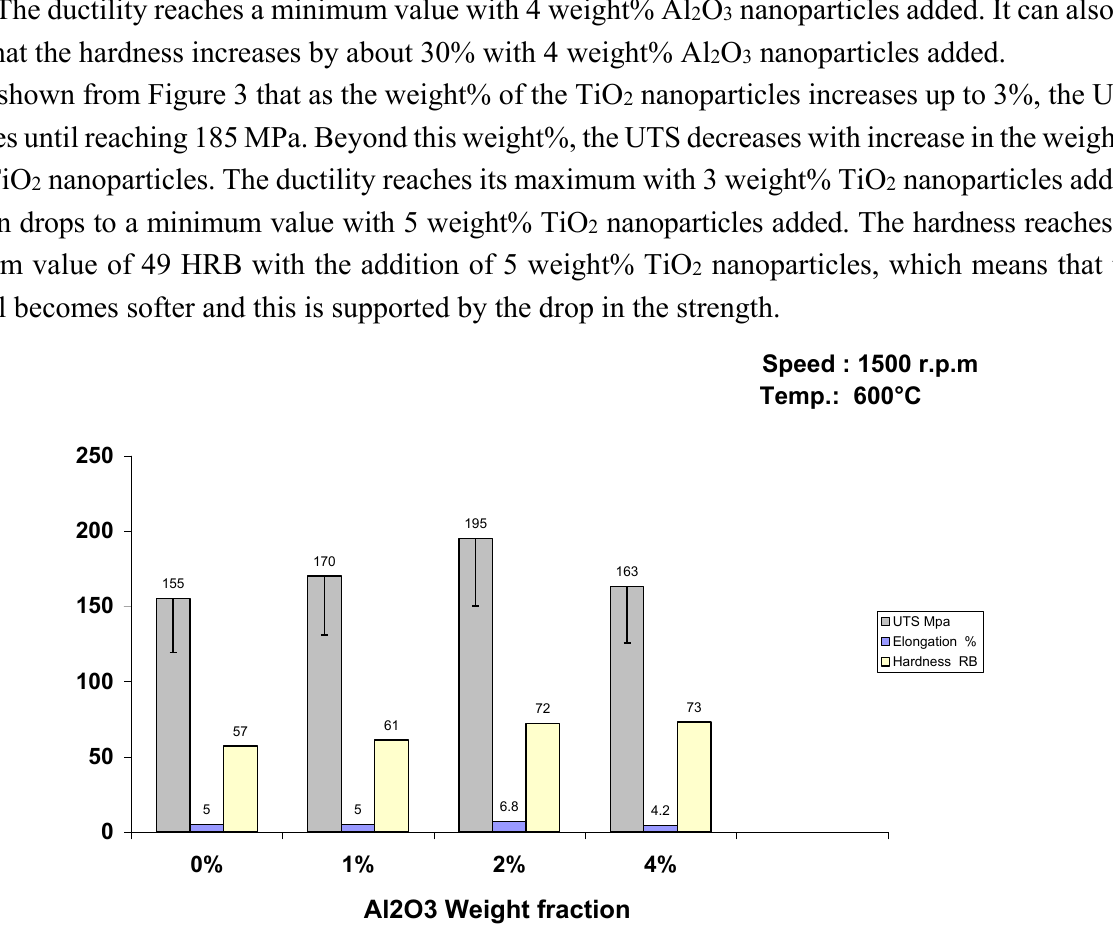
Figure 2. The effect of Al 2 O 3 nanoparticles% on the ultimate tensile strength (UTS), hardness and ductility using 1500 rpm stirring speed at semi-solid state (600